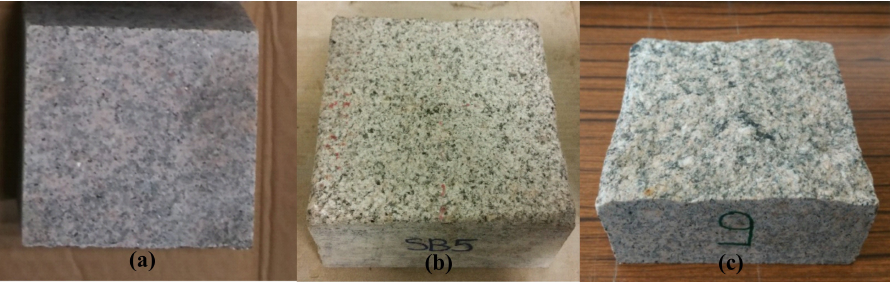
Figure 1. Types of roughness: ( a ) smooth surface; ( b ) bush-hammered surface; ( c ) natural granite